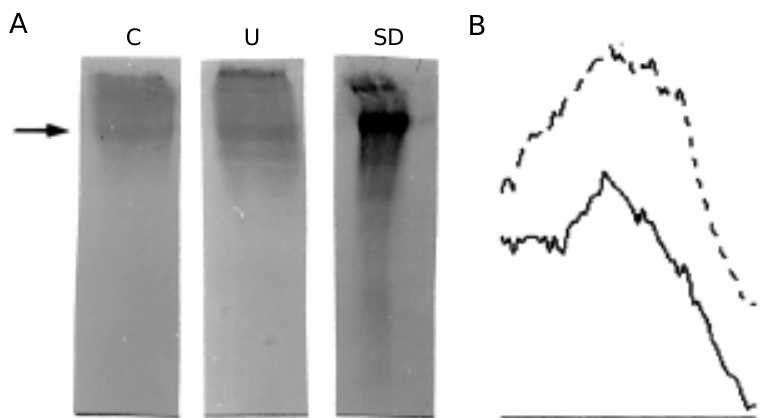
Figure 2 - Western blot reaction against fibronectin. Samples (45 µg/lane for lanes U and C and 1.5 µg of commercial fibronectin, lane SD) were separated by SDS-PAGE under reducing conditions followed by electrotransfer onto nitrocellulose membranes for immunodetection of fibronectin (A). Lane U refers to samples obtained from the undernour- ished group, lane C refers to samples obtained from the control group, and lane SD refers to commercial fibronectin run as standard. Densitometric measurement was performed (B) and the differences in band areas are shown. The solid line refers to the control sample, and the dashed line refers to the undernourished mouse sample. A similar profile was obtained in five different experiments done with the same ECM pool (control and undernourished). We tested two different groups of control and undernourished mice with similar